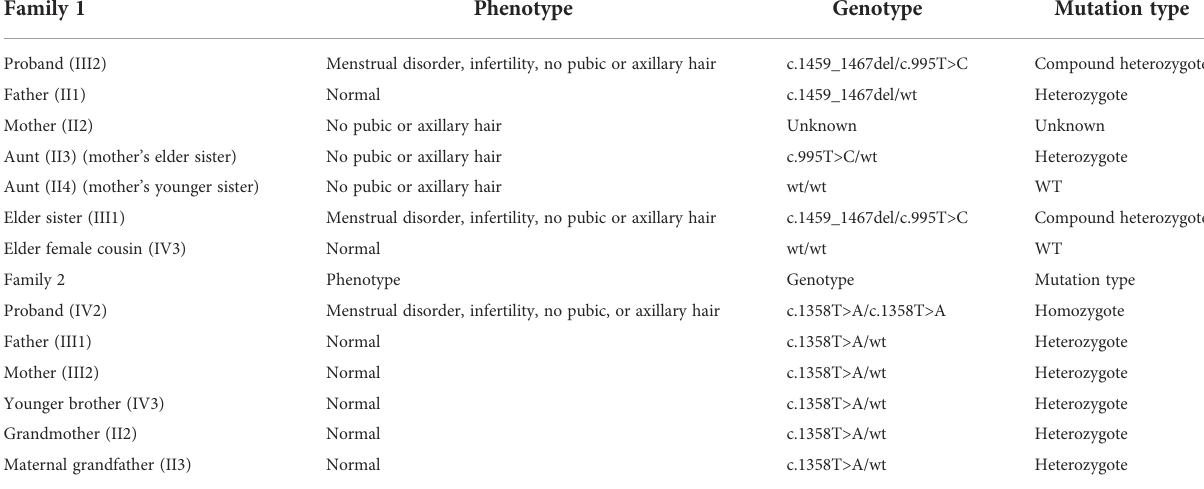
TABLE 4 The phenotypes and genotypes of the patient ’ s family members.